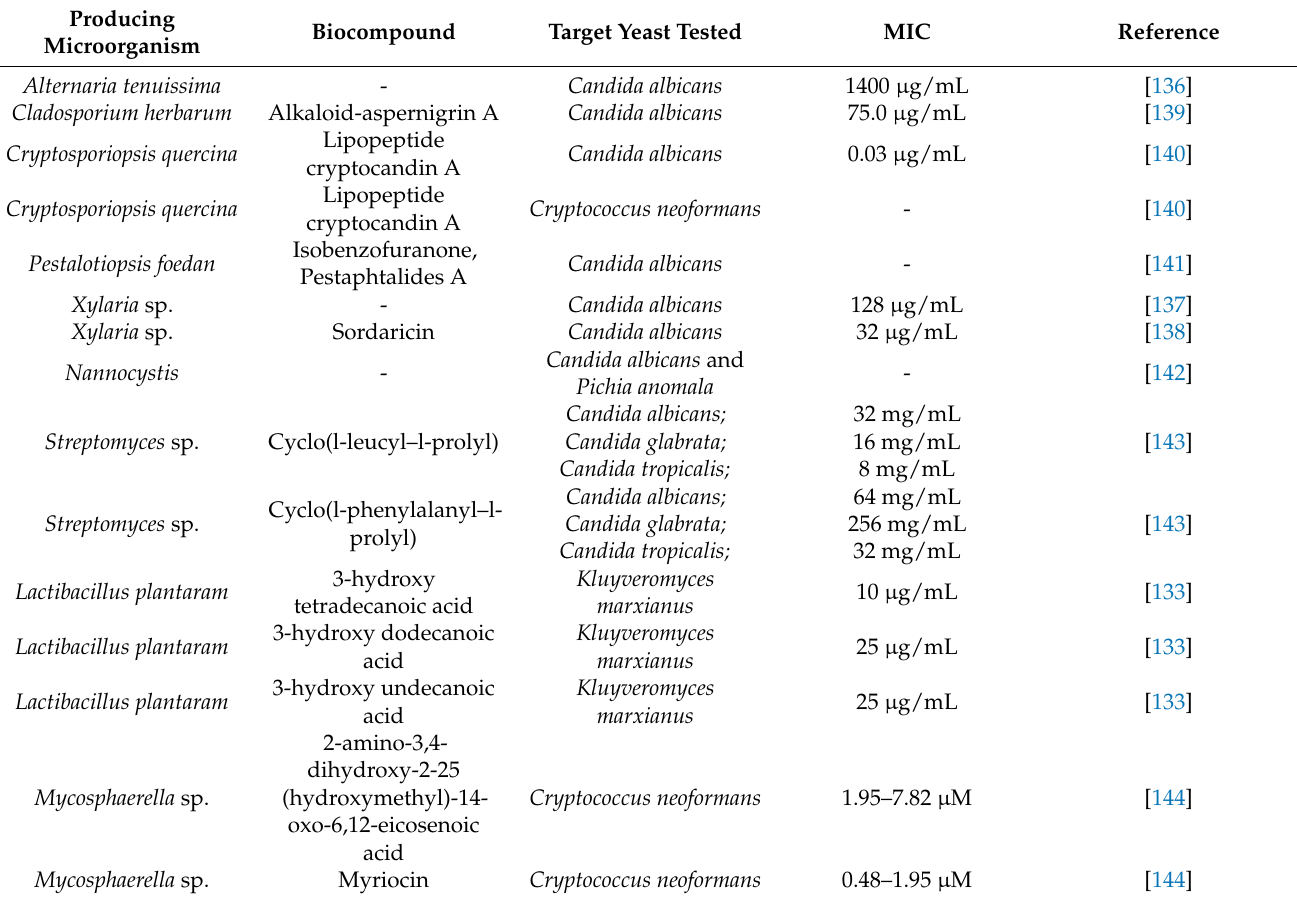
Table 2. Relation between microorganisms, biocompounds produced, targets, and